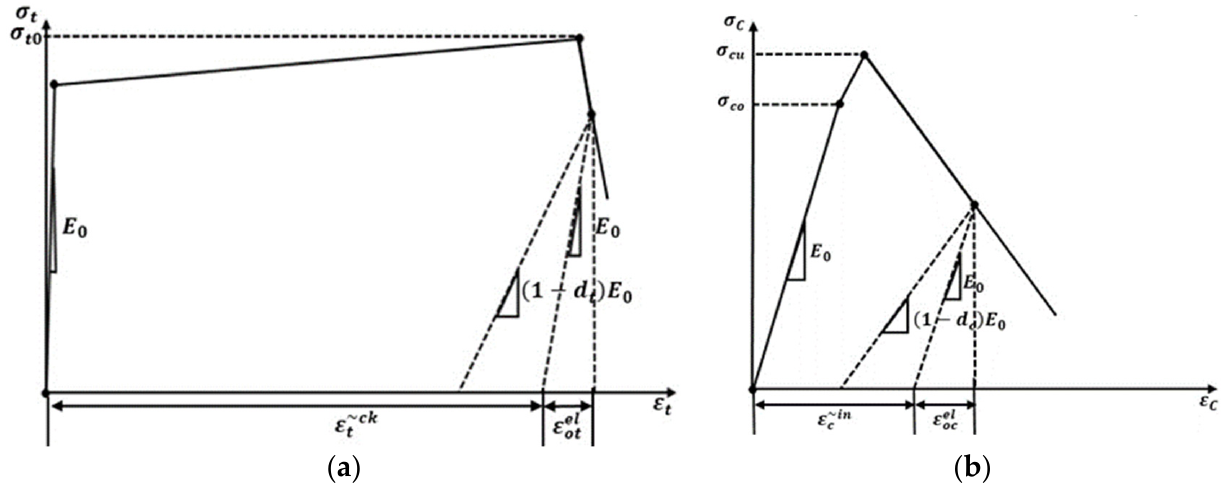
4 of 18 Figure 1. Loading pattern of the ECC beams.